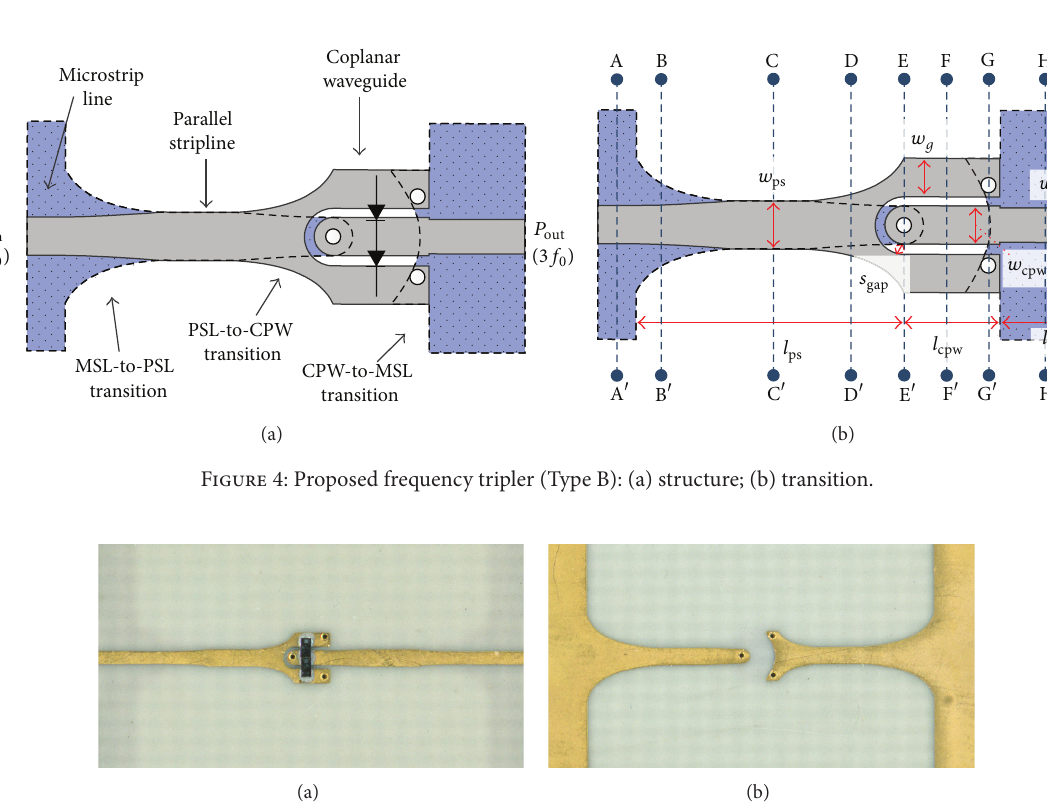
smooth electric field transformation is obtained throughout the transition as shown in Figure